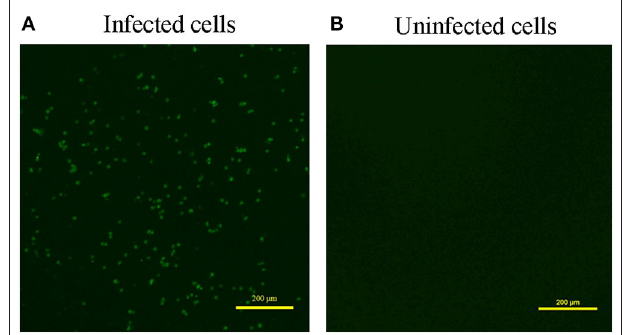
FIGURE 1 | Result of Immunofluorescence assay (IFA). (A) Infected cells. (B) Uninfected cells. IFA detection of infected MDCC-MSB1 cells and uninfected MDCC-MSB1 cells. Specific staining of the infected cells with VP3 monoclonal antibody was observed by fluorescence microscopy. Scale bar: 200 µ